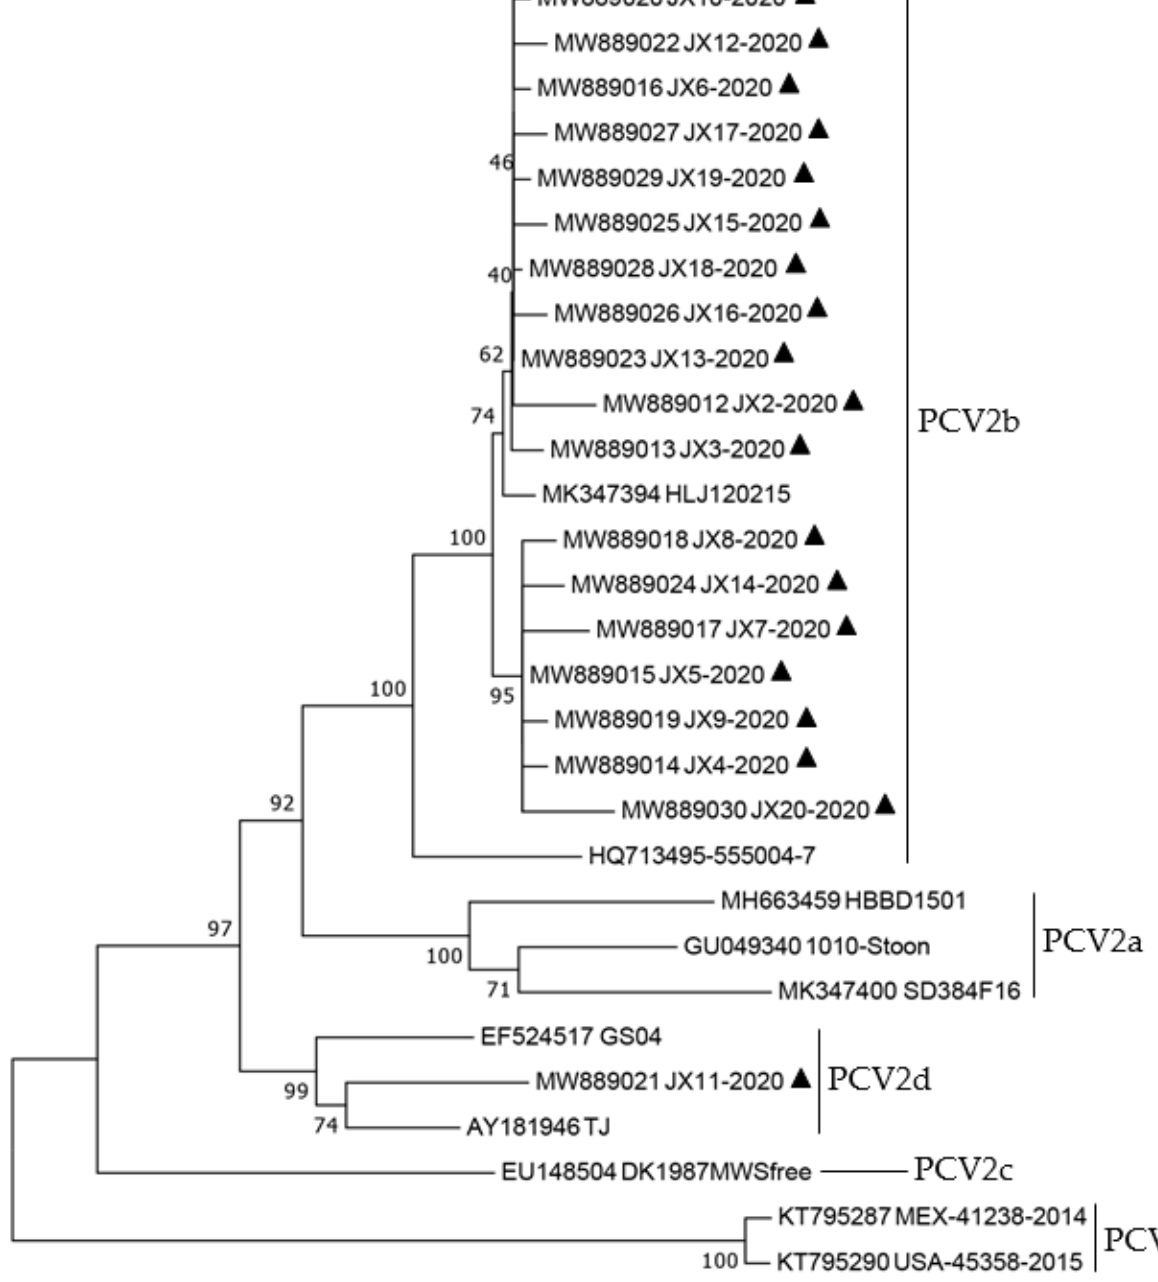
Figure 3. Phylogenetic tree based on the complete genome of all sequences (19 PCV2 sequences amplified in this study and 10 PCV2 reference sequences). The sequences obtained in this study were marked with black triangle. Phylogenetic tree was conducted by using the p-distance-based neighbor-joining (NJ) method with bootstrap analysis of 1000 replicates in MEGA 7.0 software.